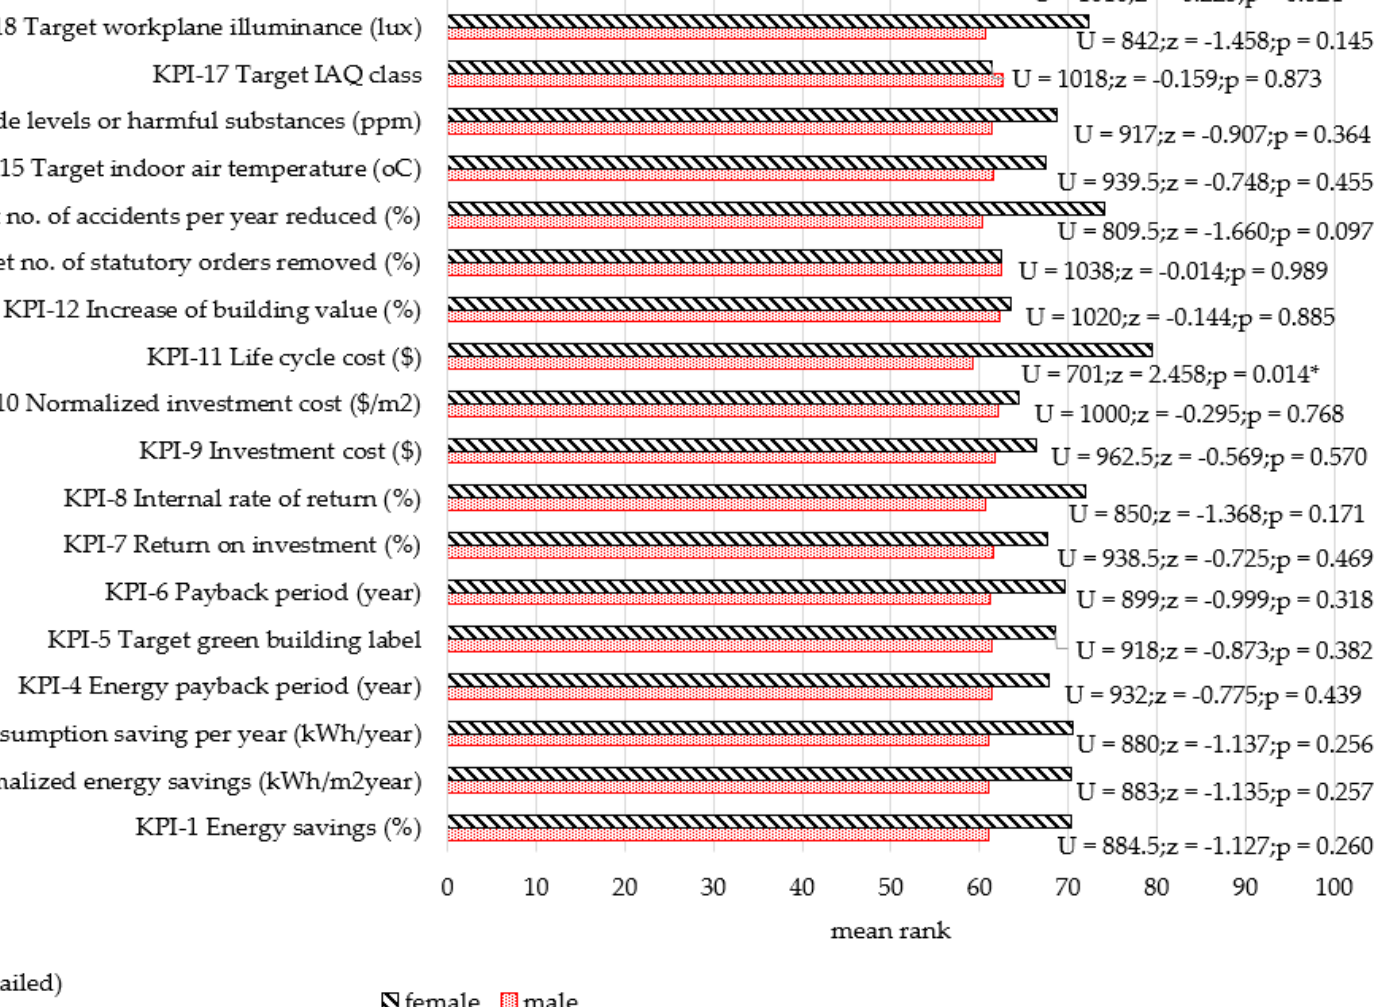
Figure A4. Mann – Whitney U-test results of G1 (gender). Figure A4. Mann–Whitney U-test results of G1